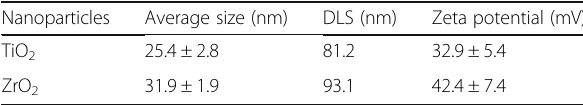
Table 2 Characterization of the TiO 2 andZrO 2 NPs